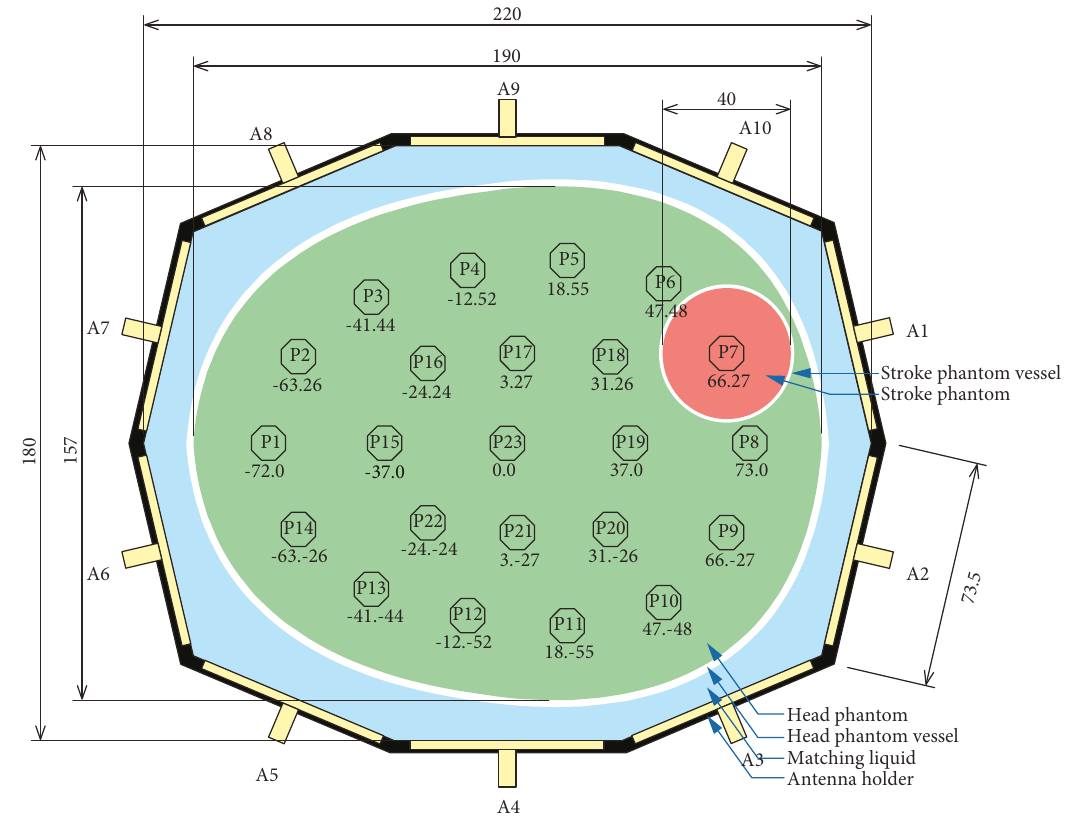
Figure 1: Bottom view of measuring container with marked positions of the stroke phantoms. Black: walls of the antenna holder, yellow: antennas with ports, blue: matching liquid, white: head phantom vessel, green: liquid phantom of human head, and red: liquid phantom of stroke at position P7 (all dimensions are in mm).